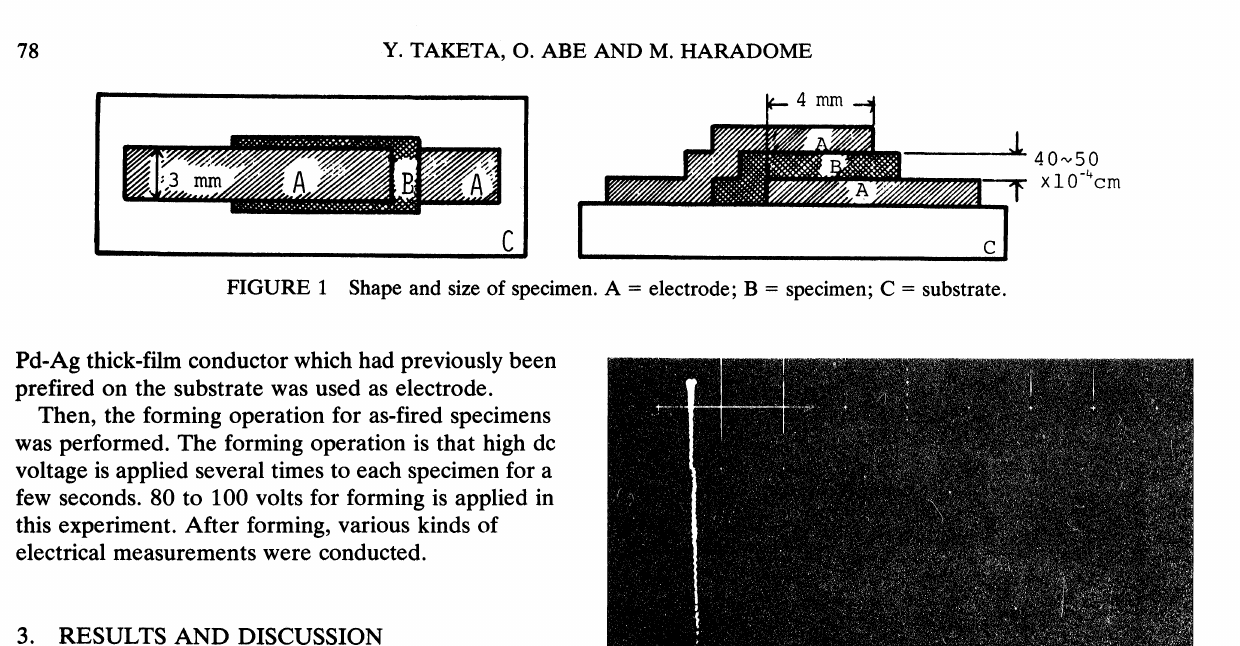
FIGURE 3 DC V-I characteristic for the low resistance state after switching. Horizontal scale is 10 V/div and vertical scale 5